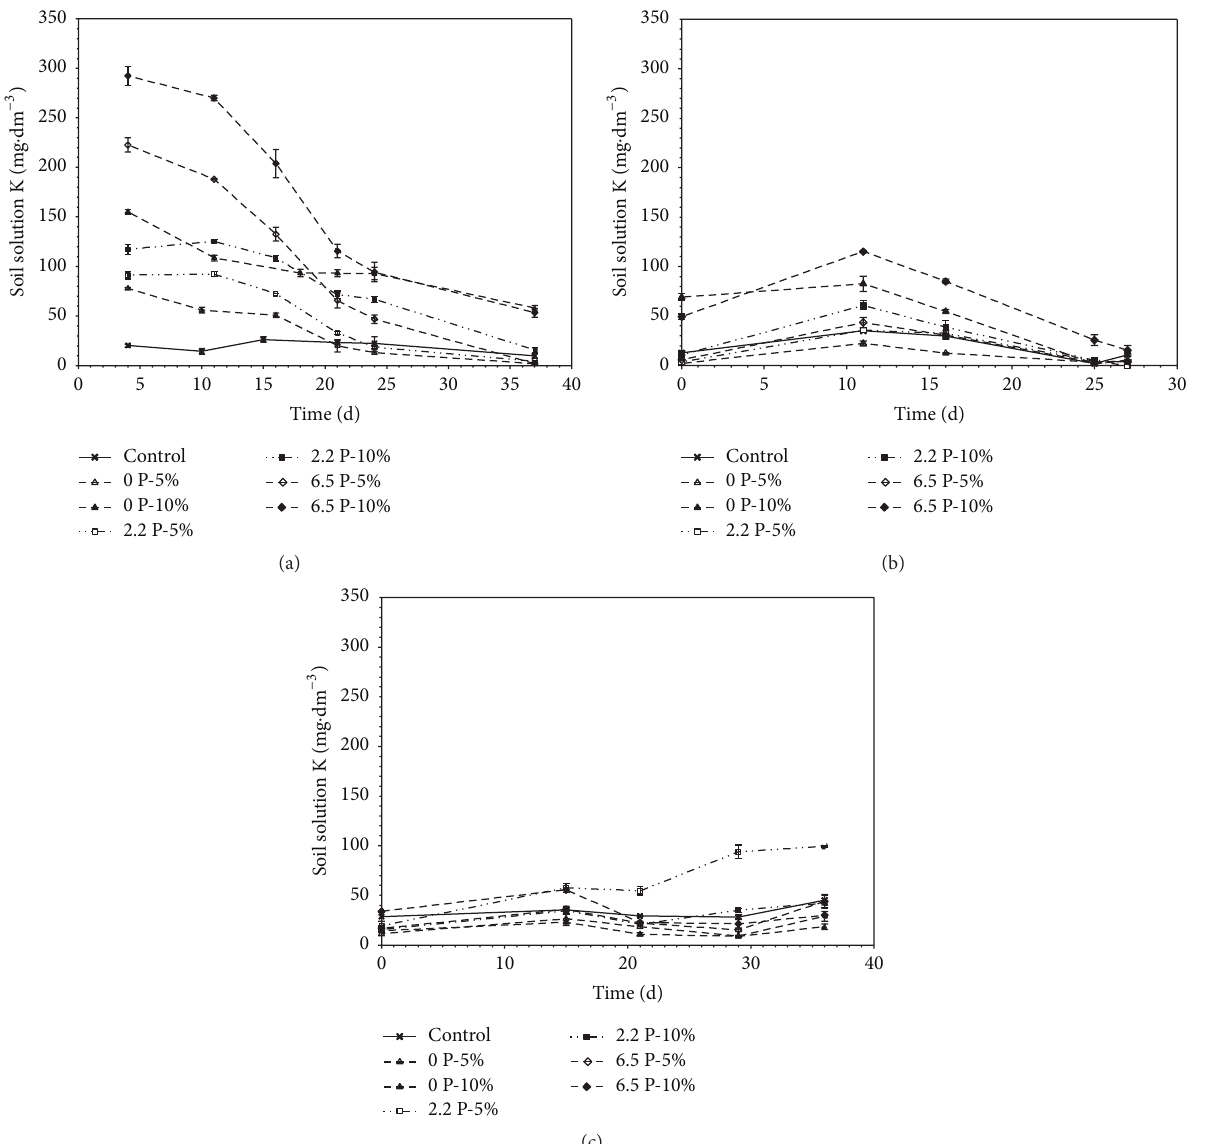
Figure 2: Potassium concentration in bulk solutions of root media amended with no soil material (control) and six soil material treatment combinations containing 5 or 10% soil material (v: v) charged with 0, 2.2, or 6.5 mg ⋅ g −1 phosphate-P during the (a) first, (b) second, and (c) third of three successive tomato seedling crops. Bars indicate ± SE ( 𝑛 = 3 ). Lines connecting data points were included to aid in visualizing trends in the